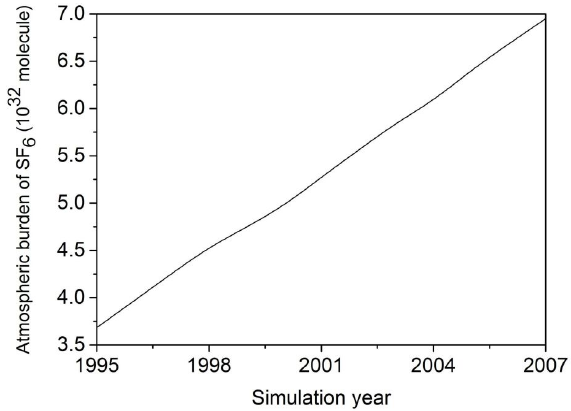
Figure 4. Variation of the total annual atmospheric burden of SF 6 during the simulation from 1995 to 2007. According to this the emission rate (slope) was determined to be 6.5 × 10 − 3 Tgyr − 1 , corresponding to 0.29pptvyr − 1